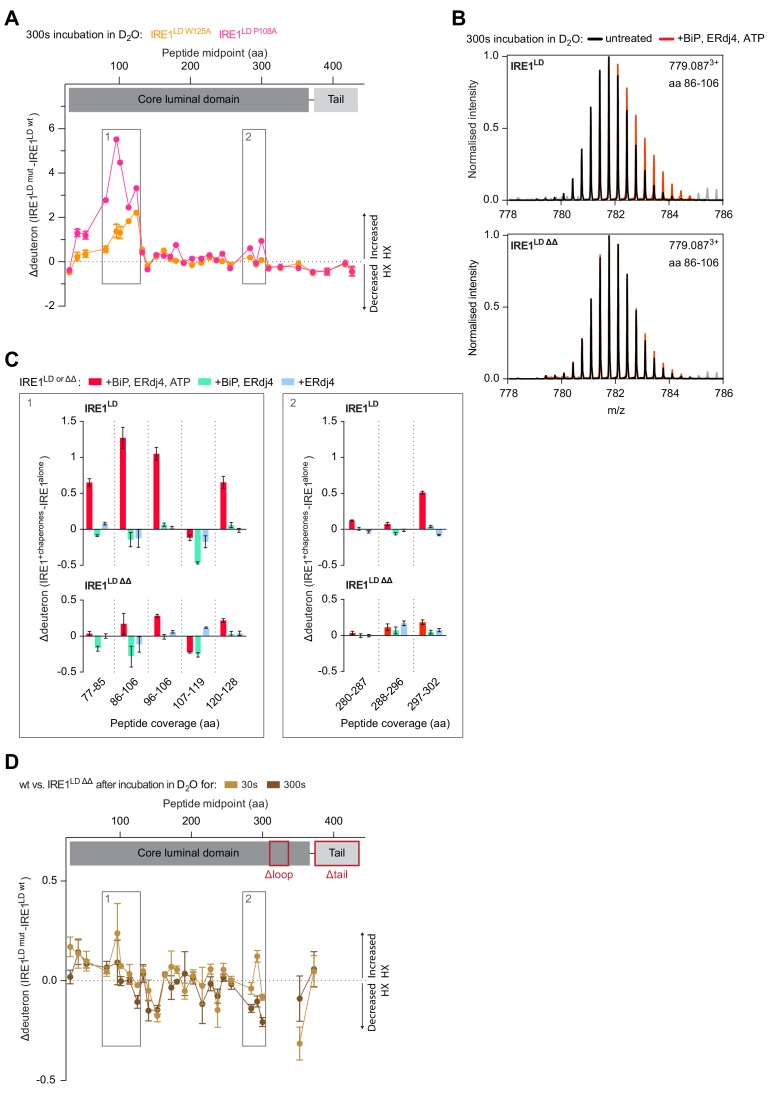
HX-MS evidence for impaired BiP- and ERdj4-driven monomerisation of IRE1LD ΔΔ.(A) Difference plot of deuteron incorporation into the indicated peptic peptides of wild-type (wt) versus IRE1LD W125A or wt versus IRE1LD P108A after 300 s incubation in D2O (as in Figure 6A) (see Figure 6—source data 1). (B) Overlay of representative spectra showing the isotope cluster of peptic fragment 779.0873+ (residues 86–106) from wt or IRE1LD ∆∆, untreated (black) or exposed to BiP, ERdj4 and ATP (red) after 300 s incubation in D2O. Peaks arising from overlapping BiP peptides are coloured in grey. Note the stronger shift of the peaks towards higher m/z values (indicating an increased deuteron incorporation) in case of wt IRE1LD in presence of BiP, ERdj4 and ATP. (C) Difference plot of the deuteron incorporation between the untreated sample and samples exposed to the indicated additives. The data for the same peptic peptides from wt and the IRE1LD ΔΔ mutant are displayed separately (as in Figure 6C, but after 300 s incubation in D2O) (see Figure 6—source data 2) (D) Difference plot of deuteron incorporation into the indicated peptic peptides of wt versus IRE1LD ∆∆ mutant after 30 or 300 s incubation in D2O as in Figure 6A (in absence of chaperones). Regions deleted in IRE1LD ΔΔ are excluded from the difference plot.Figure 6—figure supplement 1—source data 1.Source data for Figure 6—figure supplement 1E.